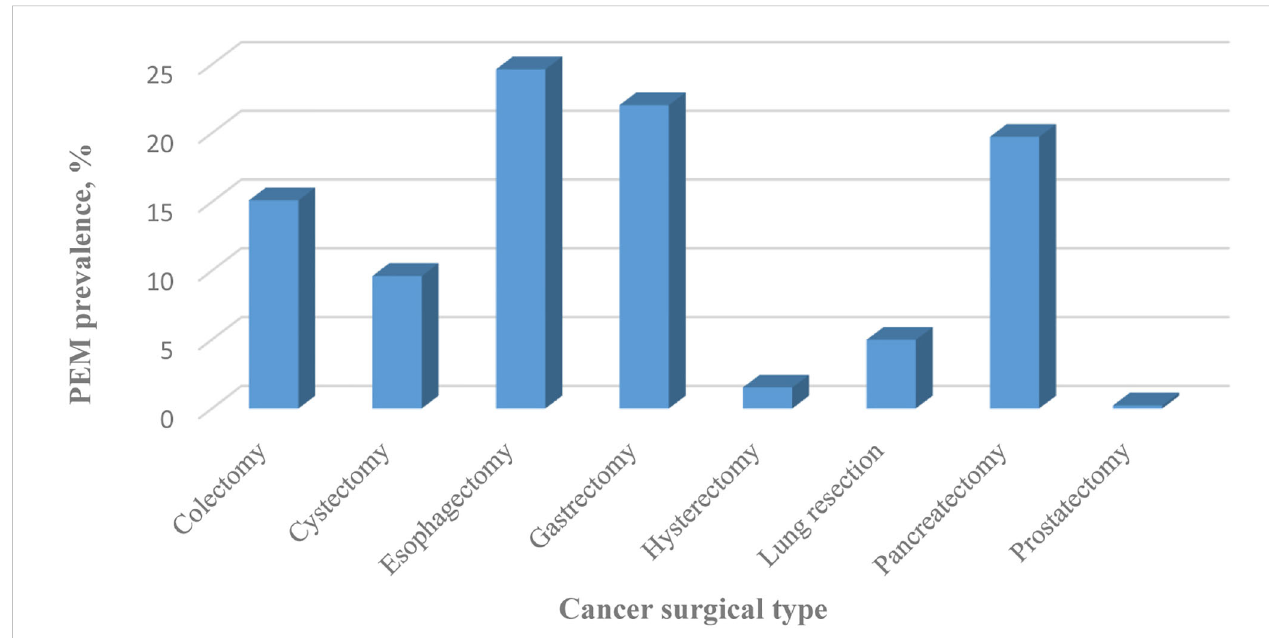
FIGURE 1 Prevalence of PEM classi fi ed by cancer surgery type between 2009 and 2015 in the United